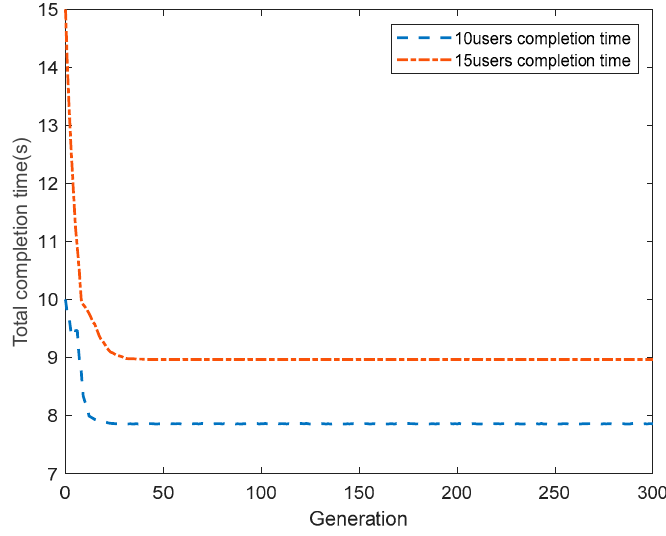
Figure 5. Total completion time with generation times.